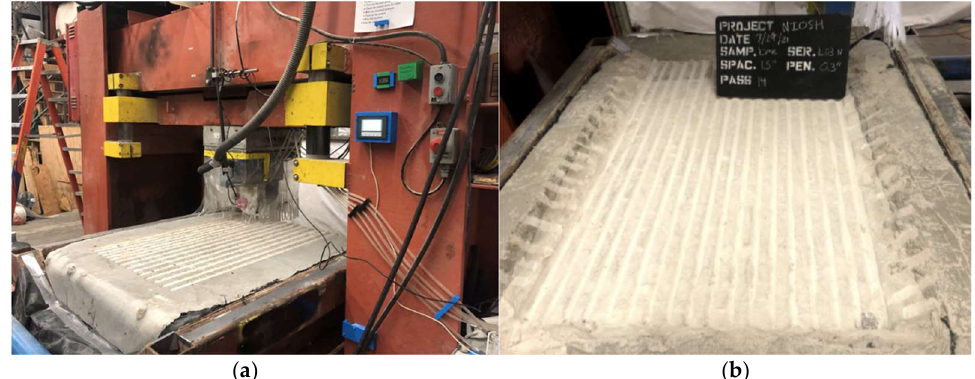
Figure 2. Images of ( a ) LCM with the limestone block installed and dust curtain around the pick; ( b ) The surface of the limestone block surrounded by concrete after the completion of a pass at 1.5-inch spacing across the